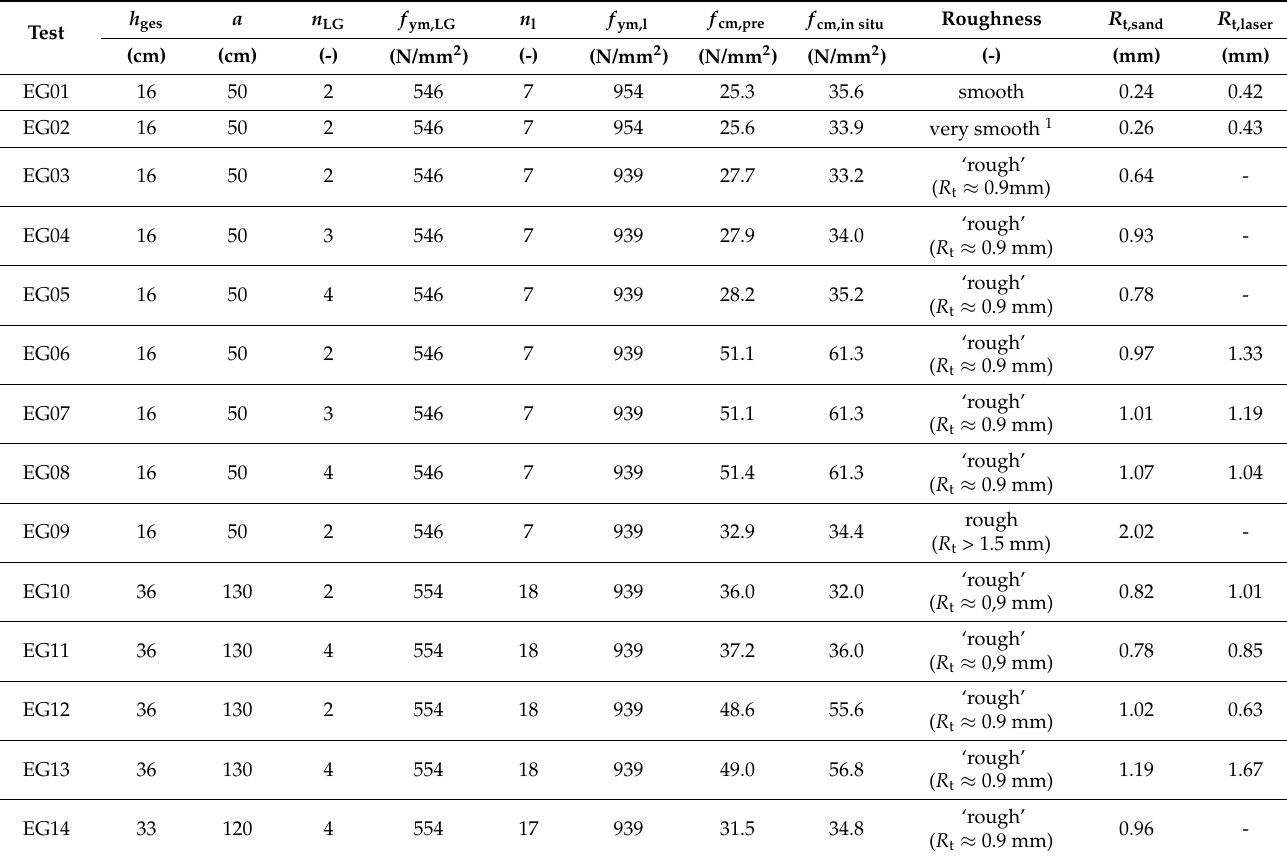
Table 4. Parameters and material properties of test specimens.